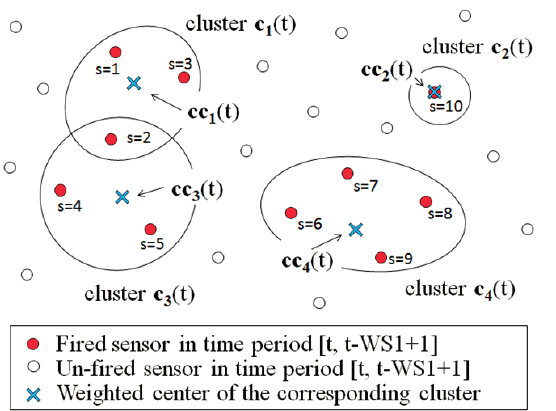
Figure 3. Clustering algorithm.